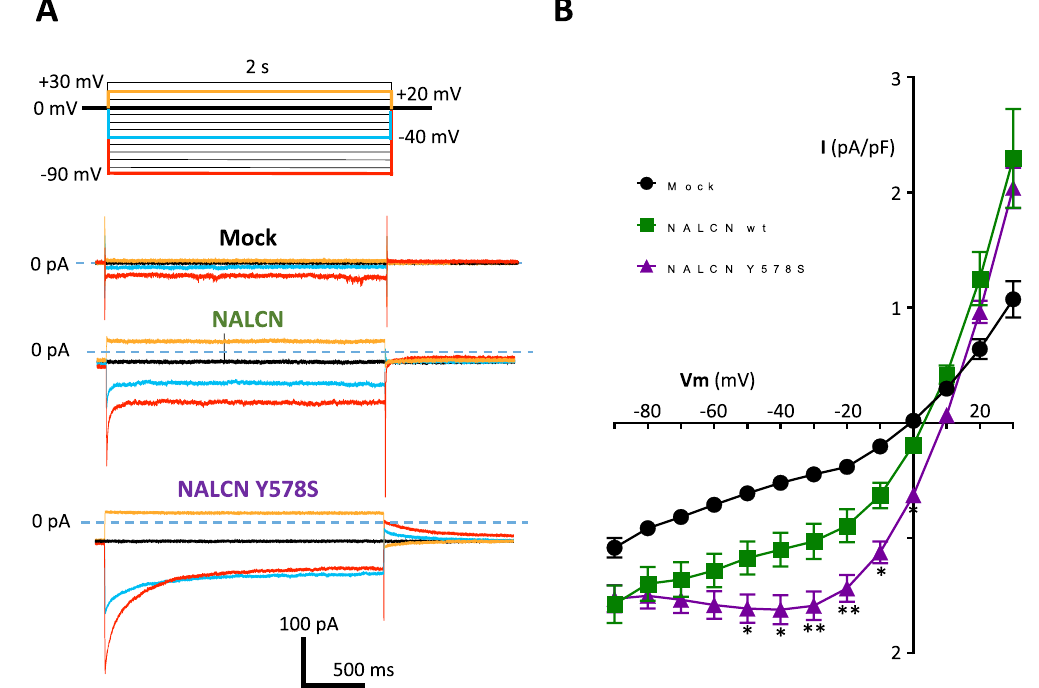
Figure 4. Current-voltage (I/V) relationship of the steady-state NALCN current for wild-type (wt) and its CLIFAHDD variant Y578S in differentiated NG108-15 cells. ( A ) Representative current traces elicited by a membrane voltage step protocol (test pulses from − 90 mV to + 30 mV) from a HP at 0 mV, for a mock- transfected cell (top), a NALCN (wt)-transfected cell (middle), a NALCN (Y578S)-transfected cell (bottom). Only the current traces obtained for the test-pulses at − 90 mV (in red), − 40 mV (in blue), 0 mV (in black) and + 20 mV (in orange) are shown. ( B ) Corresponding I/V relationships for mock transfected cells (black circles, n = 44), NALCN wt (green squares, n = 45) and its pathogenic variant NALCN Y578S (purple triangles, n = 73). Statistical significance was calculated with a Tukey’s multiple comparisons